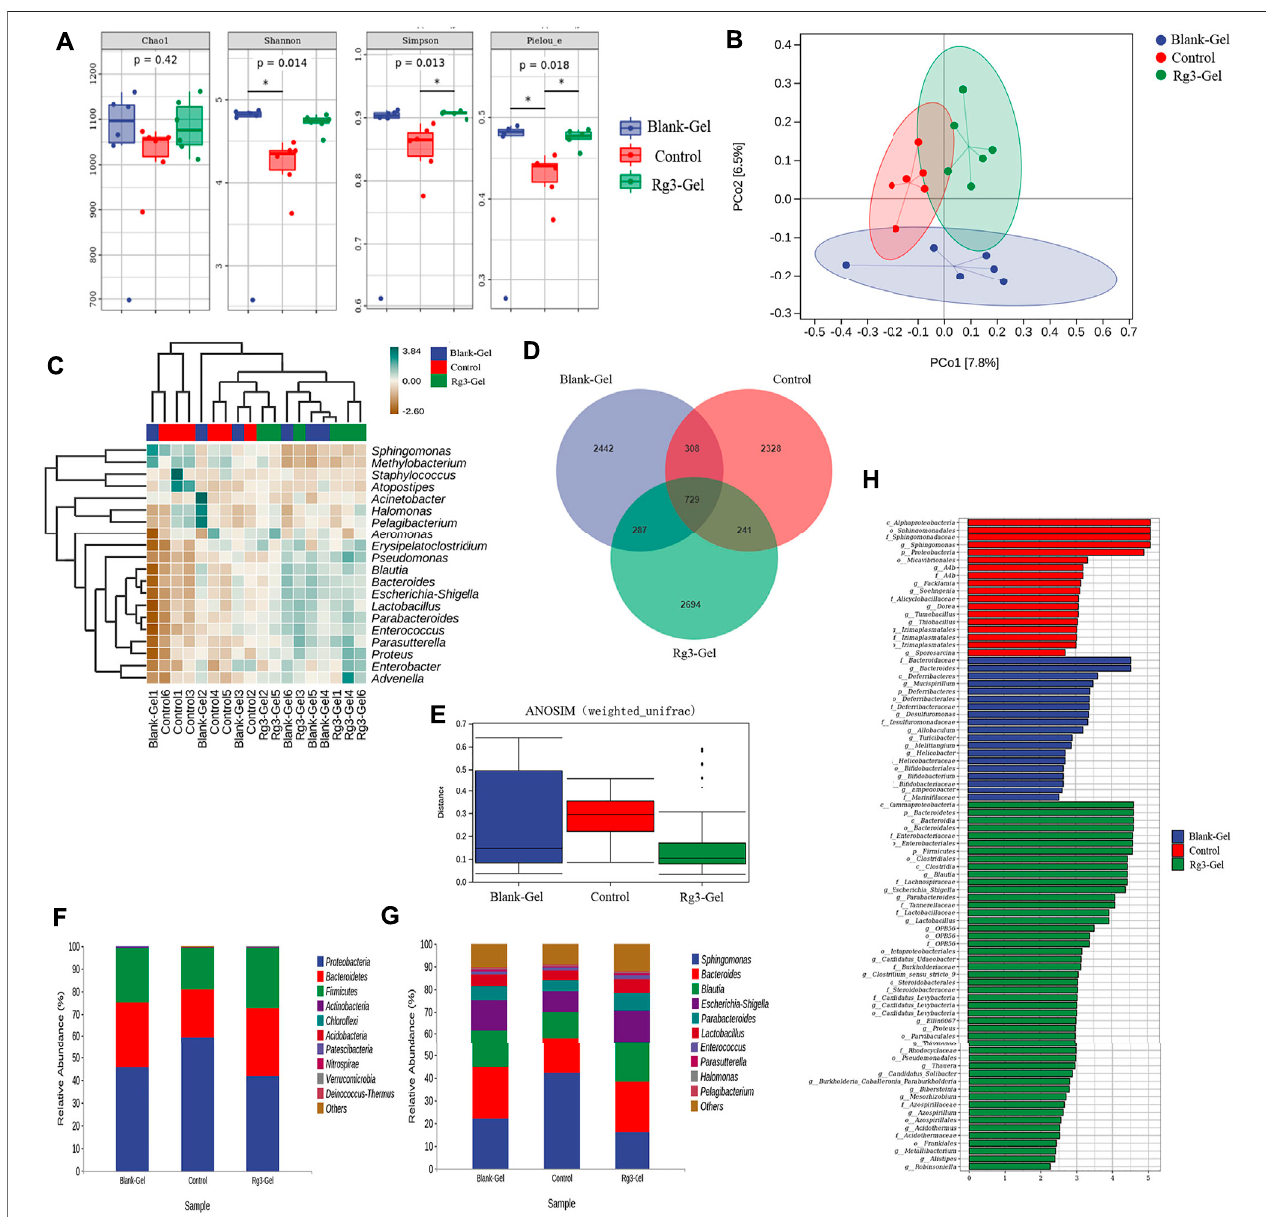
FIGURE 8 | Effects of different treatments on wound fl ora. (A) Box plots of four different alpha diversity measures. (B) Multivariate analysis of beta-diversity: PCoA results based on weighted UniFrac (consider sequencing amounts when analyzing) across the three different sample groups. Blue, red, and green colors represent samples from Blank-Gel, Control, and Rg3-Gel individuals, respectively. (C) Correlation heatmap between three groups important differential wound microbes and the top20generainabundance. (D) Venndiagramofsharedanduniquebacterialgeneraintheskinwoundmicrobiome. (E) OnewayANOSIManalysis(teststatisticR > 0). (F) (G) Histogram ofspecies distribution was used to compare the differences of relative abundance in phylum and genus levels between different groups. (H) LDA chart. The score was obtained by LDA analysis (linear regression analysis) ( n =